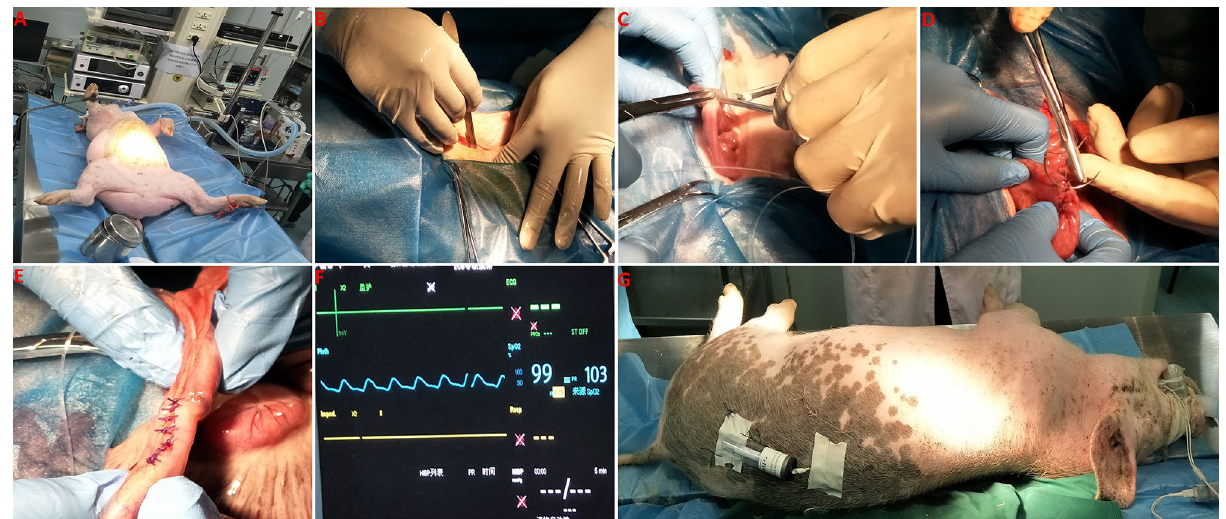
Figure 1. Implantation of ultrafiltration probes into the ileum of piglets. ( A ) each piglet was placed in left lateral recumbency on the surgical table and manually intubated orotracheally; ( B ) a vertical 10 cm skin incision was made approximately 10 cm above the midline of the abdomen and approximately 5 cm from the last rib; ( C ) A stab incision was made with a scalpel blade in the ileum, and an introducer needle was placed through the stab incision into the lumen of the ileum; ( D , E ), nodular suture of the ileum incision with 2–0 absorbable surgical suture; ( F ) the electrocardiogram, oxygen saturation, and non-invasive blood pressure via doppler were monitored throughout surgery; ( G ) the vacuum tube holder and needle are sutured to the